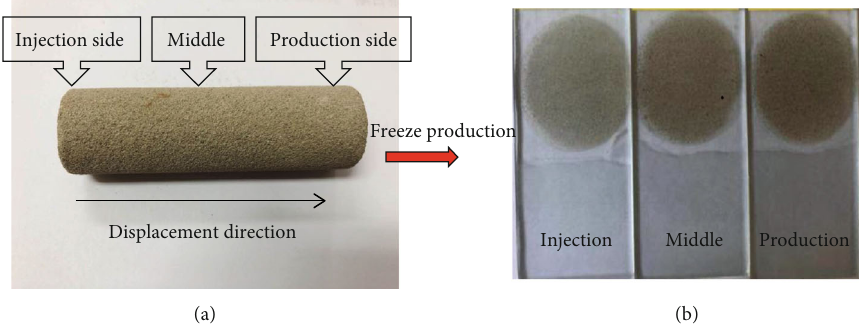
Figure 3: Core slice making process. (a) Natural core. (b) Freeze production after fl ooding